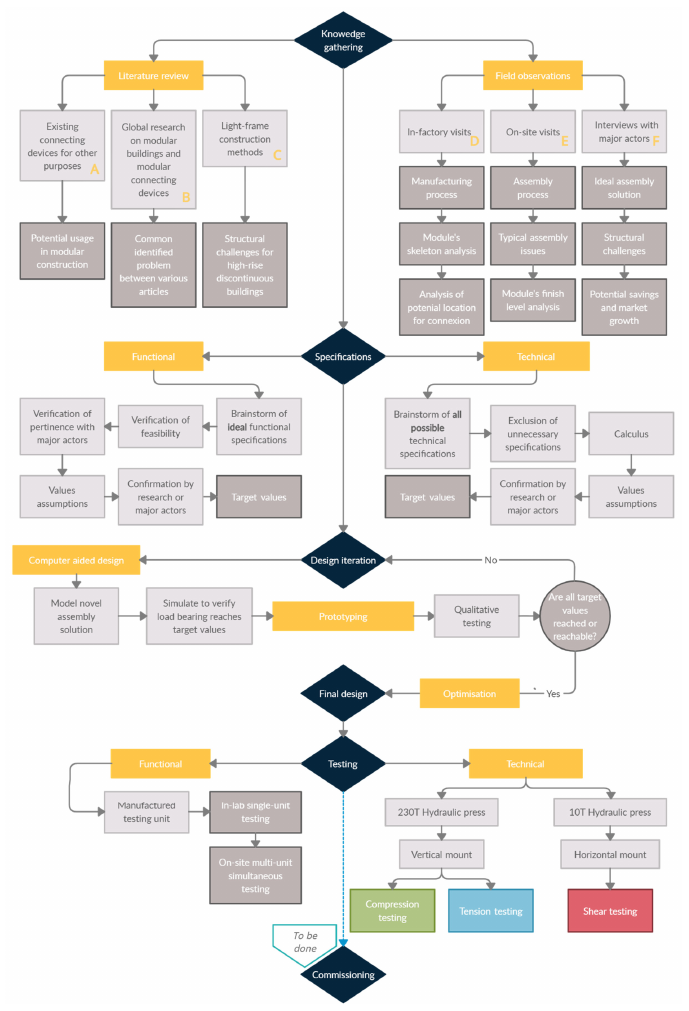
Figure 1. Specific methodology for the design of the novel connecting device.